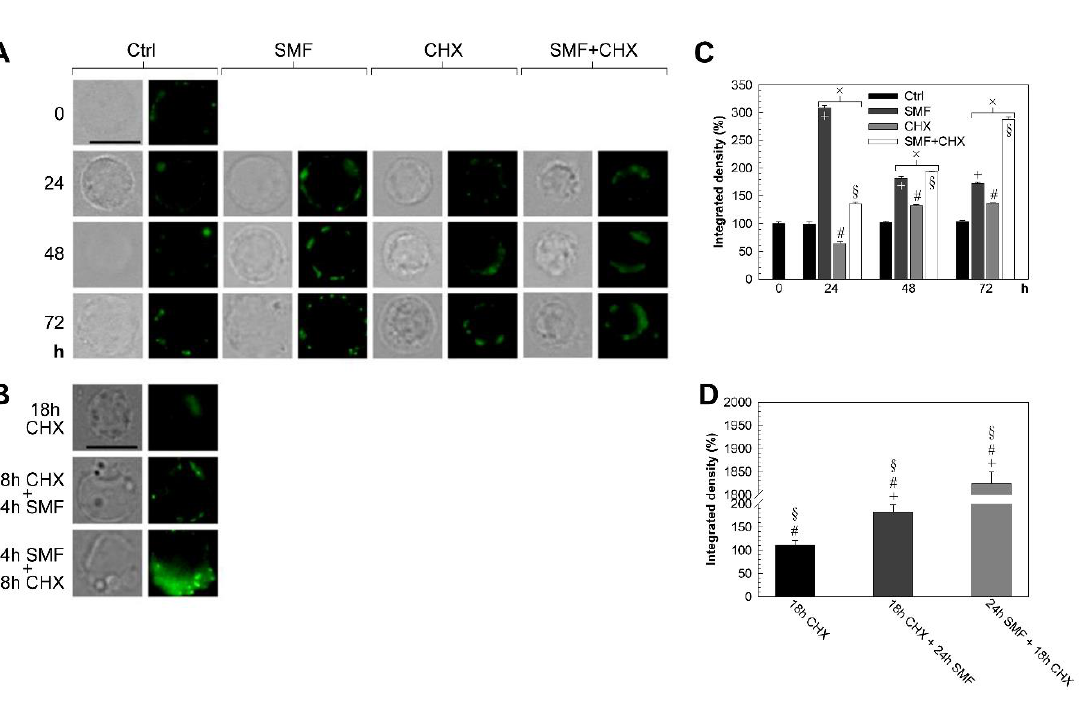
Figure 2. Cont. Figure 2.